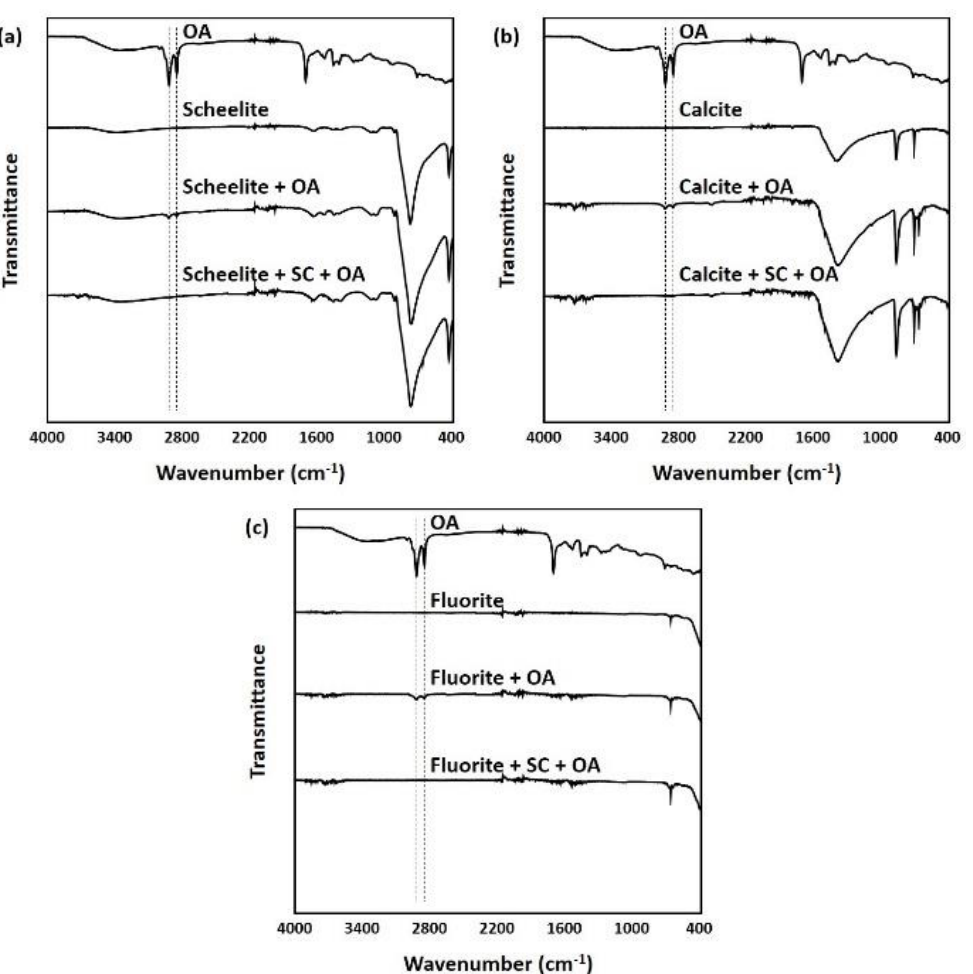
Figure 3. FTIR spectra of ( a ) scheelite, ( b ) calcite, and ( c ) fluorite in the absence and presence of flotation reagents (OA: Oleic Acid, SC: Sodium Carbonate).